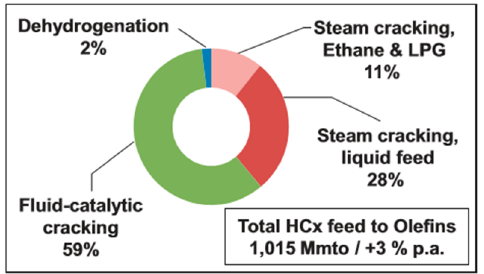
Figure 1. Olefin production methods using hydrocarbon feedstocks. Reproduced from [3]. 2014, WILEY ‐ VCH Verlag GmbH & Co.